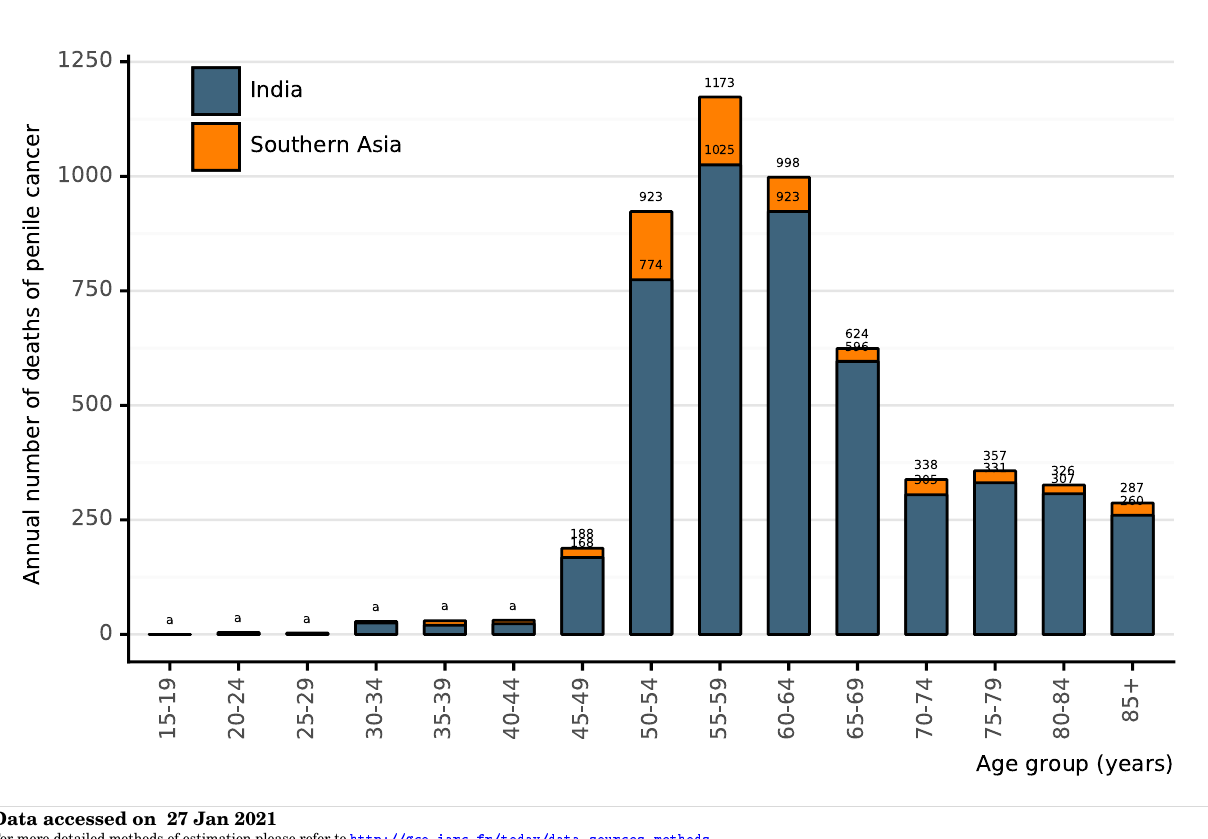
Figure 120: Annual number of new deaths of penile cancer by age group in India (estimates for